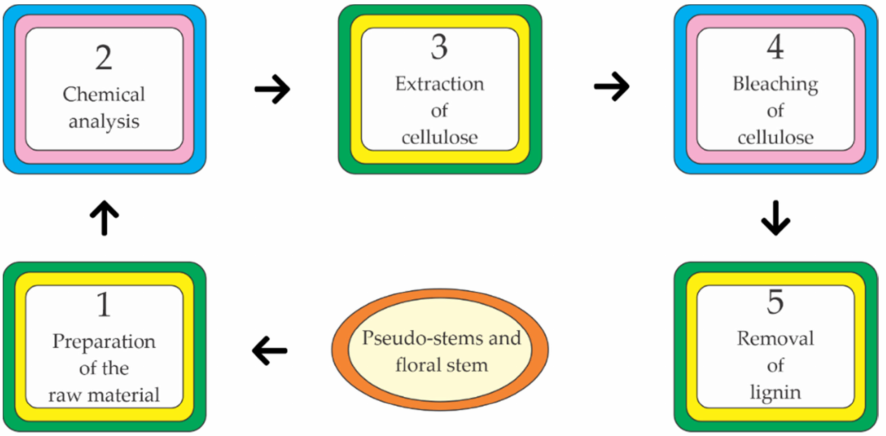
Figure 9. Cellulose extraction from the banana pseudostem and flower